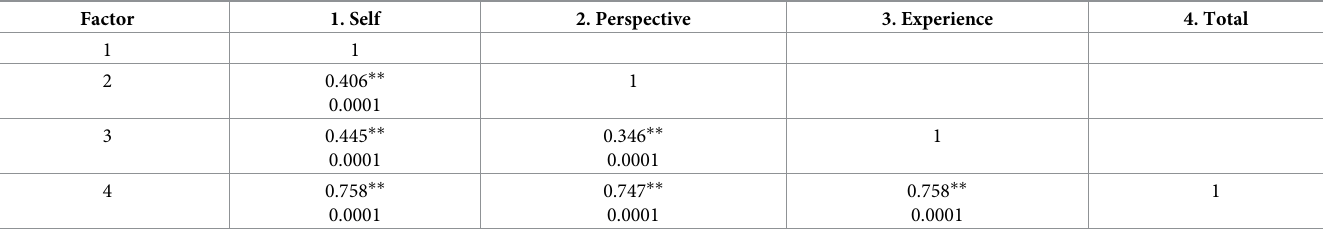
Table 4. Correlation matrix of NR